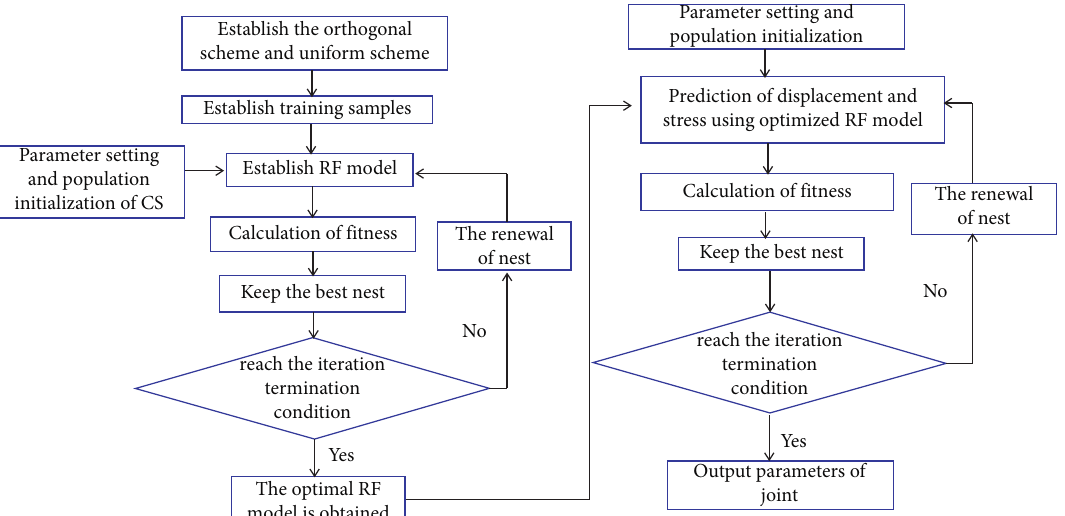
Figure 1: A flowchart of back-analysis of joint parameters.